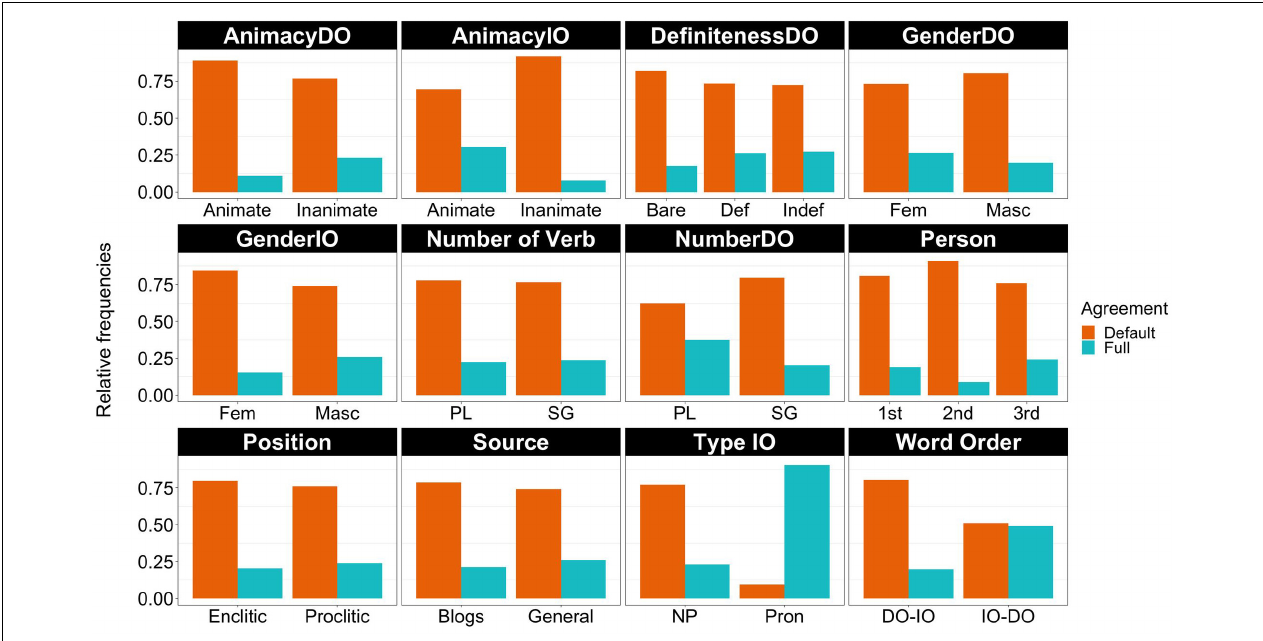
FIGURE 4 | Relative frequencies of each type of agreement by predictor